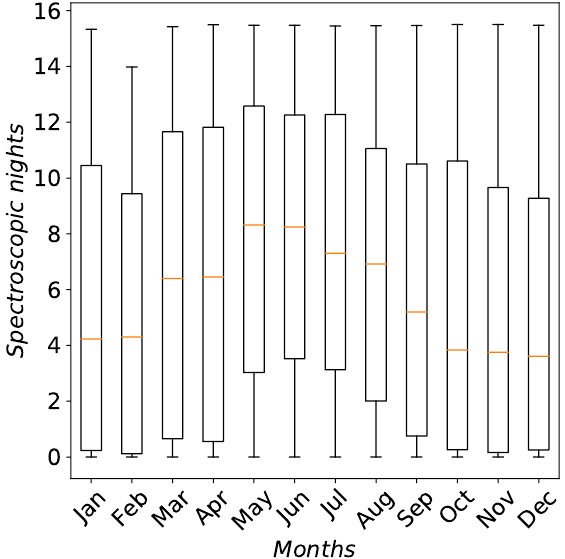
Figure 10. Box and whisker plots for spectroscopic nights during 2010–2021 at the BTA site. The central horizontal lines inside the boxes are medians; bottoms and tops of the boxes are ± standard deviation; and ends of the whiskers are the minimum and maximum